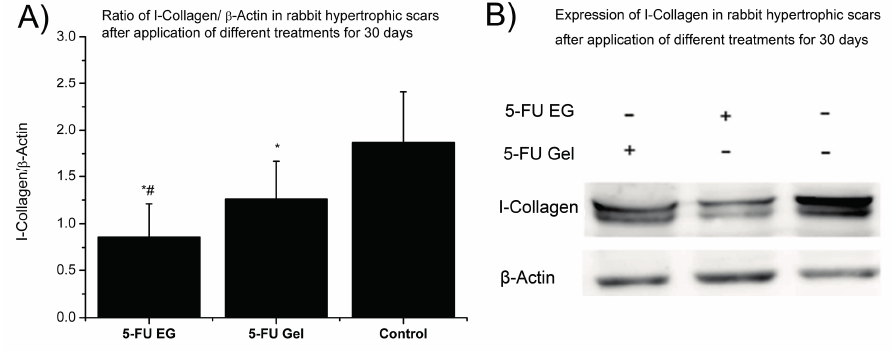
Figure 8. ( A ) Expression of I-Collagen in rabbit hypertrophic scars after application of different treatments for 30 days; ( B ) Ratio of I-Collagen/ β -Actin * p < 0.05 compared to control samples; # p < 0.05 compared to 5-FU